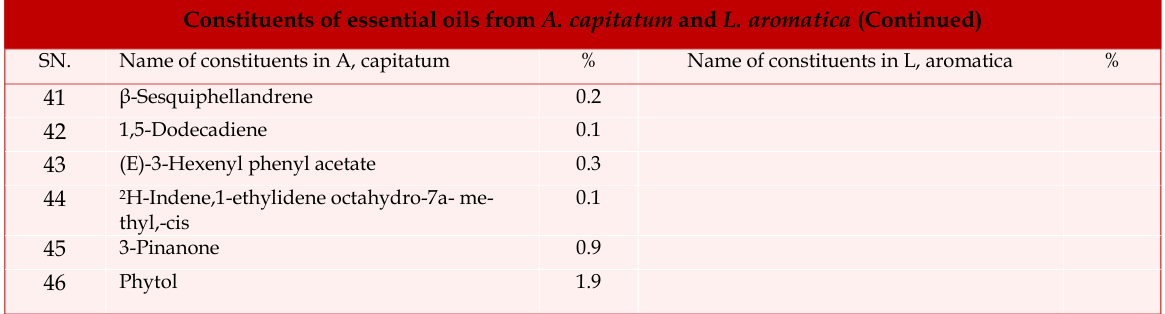
Constituents of essential oils from A. capitatum and L. aromatica (Continued)